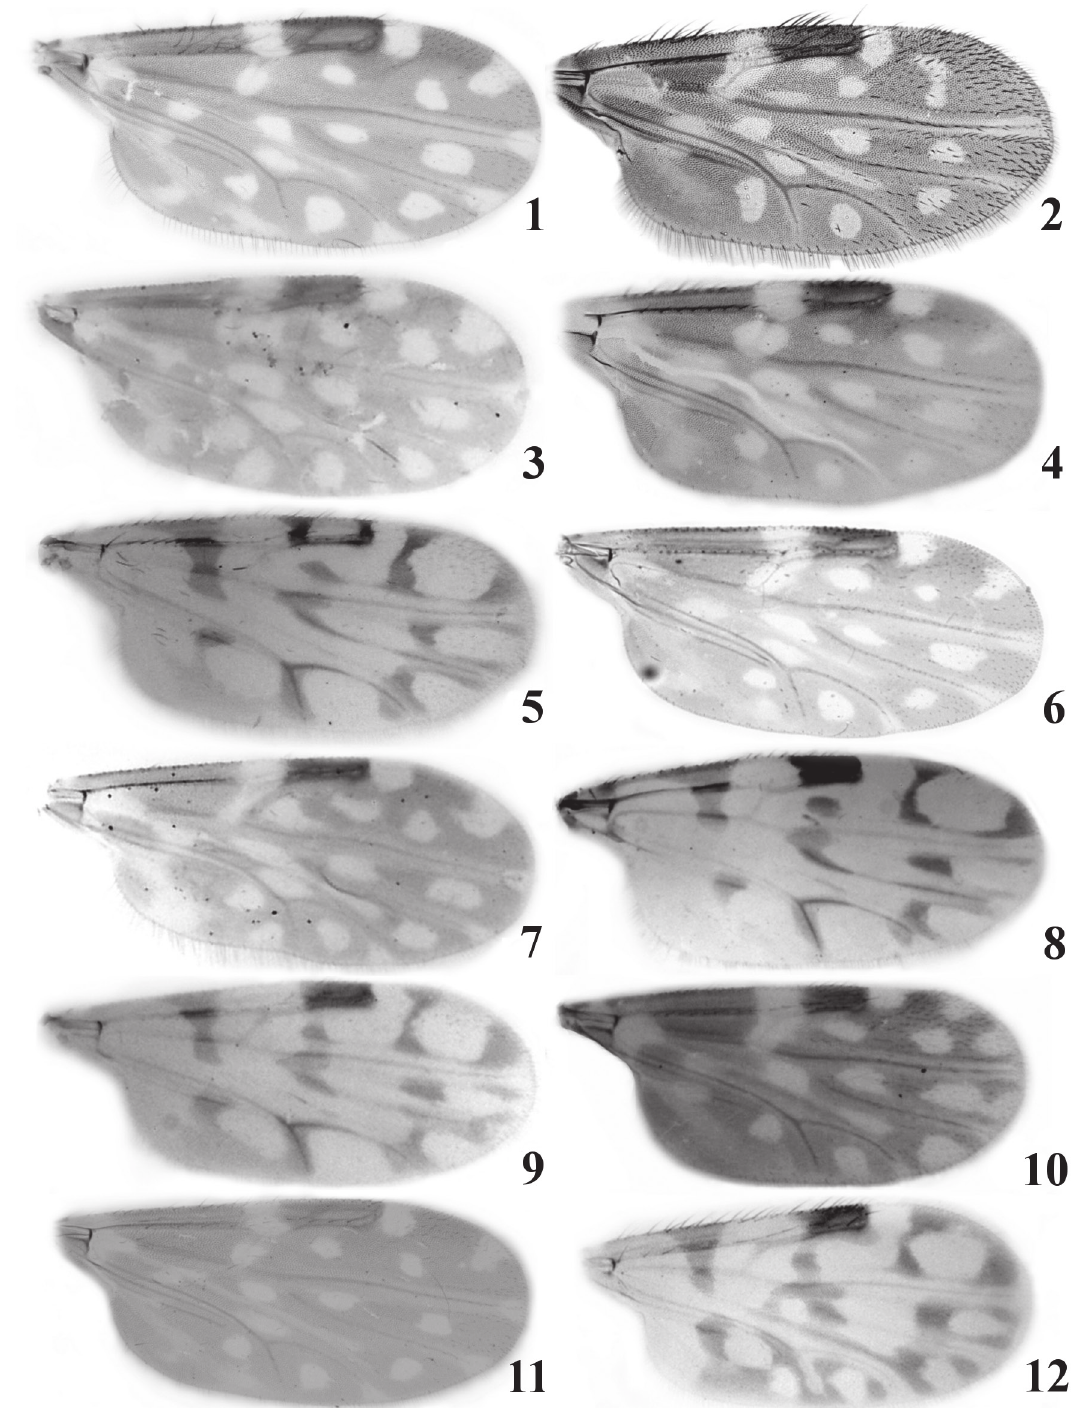
Figures 1-12 - Wing photograph of Culicoides reticulatus species group. 1. C. amazonicus . 2. C. aureus. 3. C. castelloni sp.nov. 4. C. diplus. 5. C. fittkaui. 6. C. fluminensis. 7. C. forattinii. 8. C. goeldii. 9. C. guamai. 10. C. guyanensis. 11. C. irregularis. 12. C.